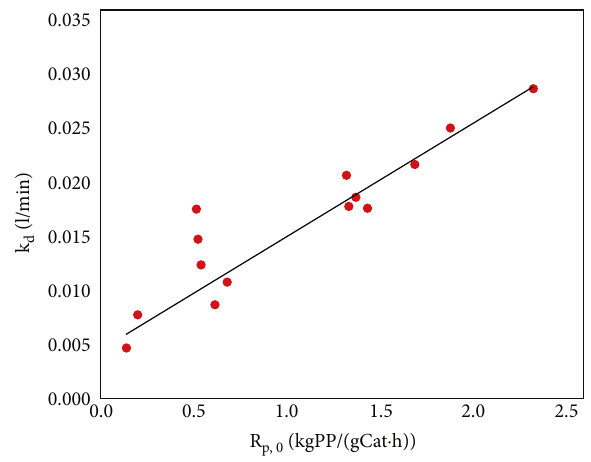
Figure 9: Deactivation constant versus initial polymerization rate.